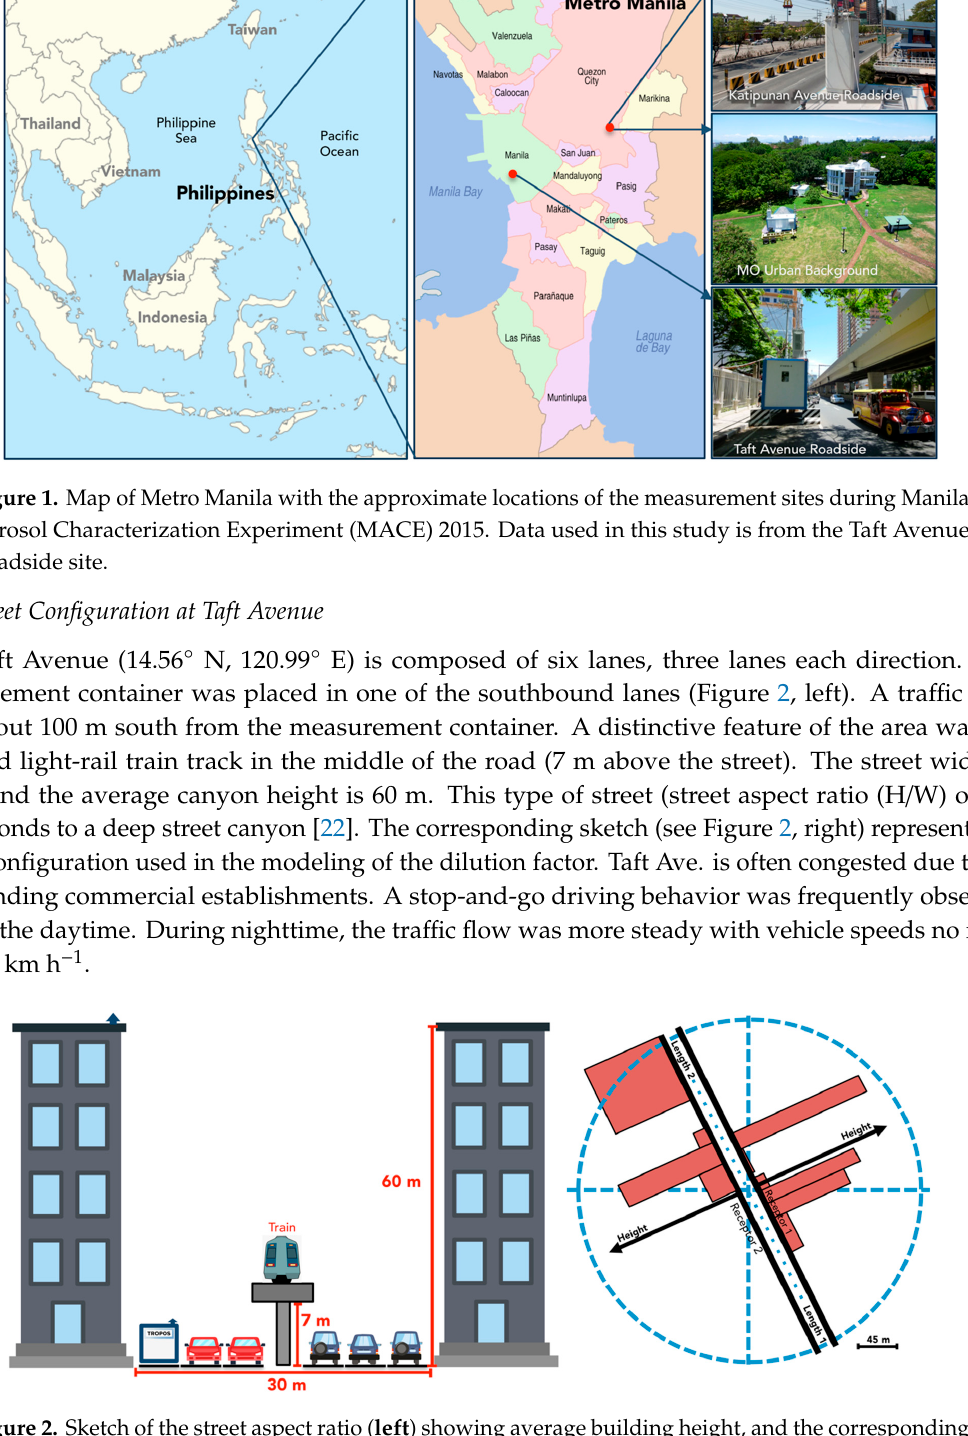
Figure 2. Sketch of the street aspect ratio (left) showing average building height, and the corresponding street configuration (right) input in the Operational Street Pollution Model (OSPM).